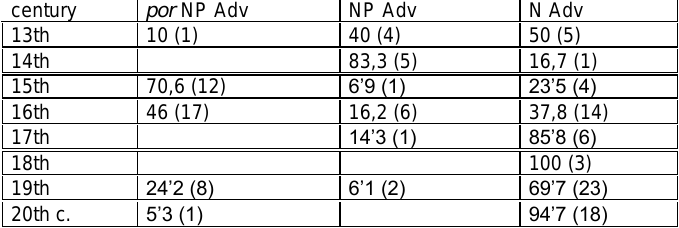
Table 3. Frequency of cuesta abajo/ayuso ‘downhill’